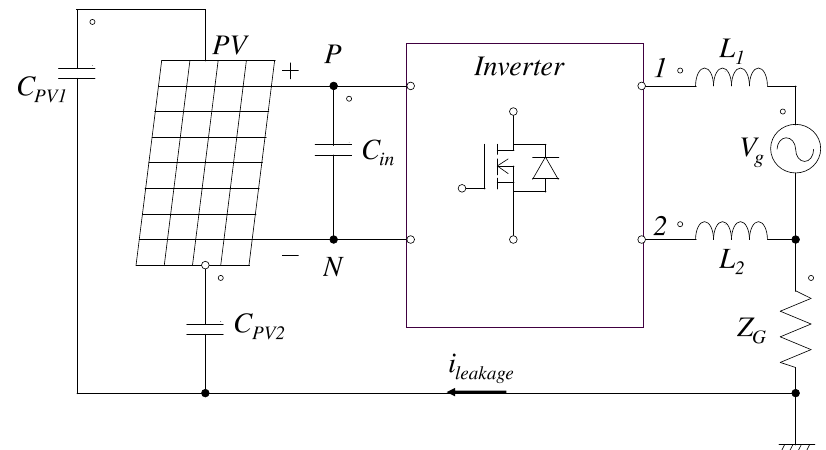
Figure 5. Equivalent circuit of a common-mode single-phase transformerless topology [54].